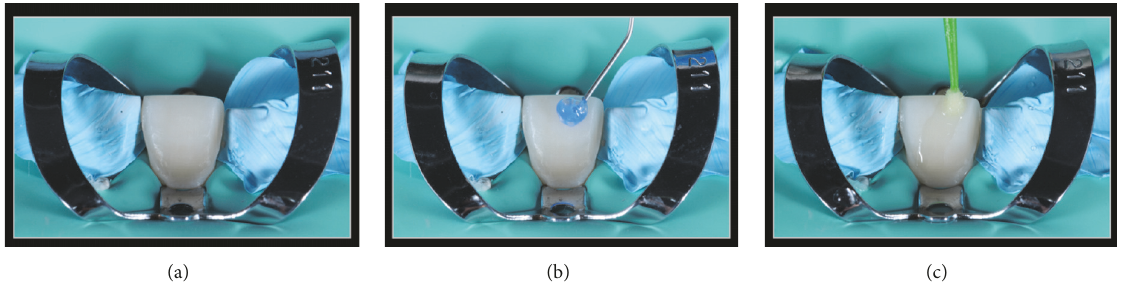
Figure 16: Treatment of the enamel surface for bonding. (a) Tooth 11 under rubber dam isolation. (b) 37% phosphoric acid etching. (c) Bonding application.